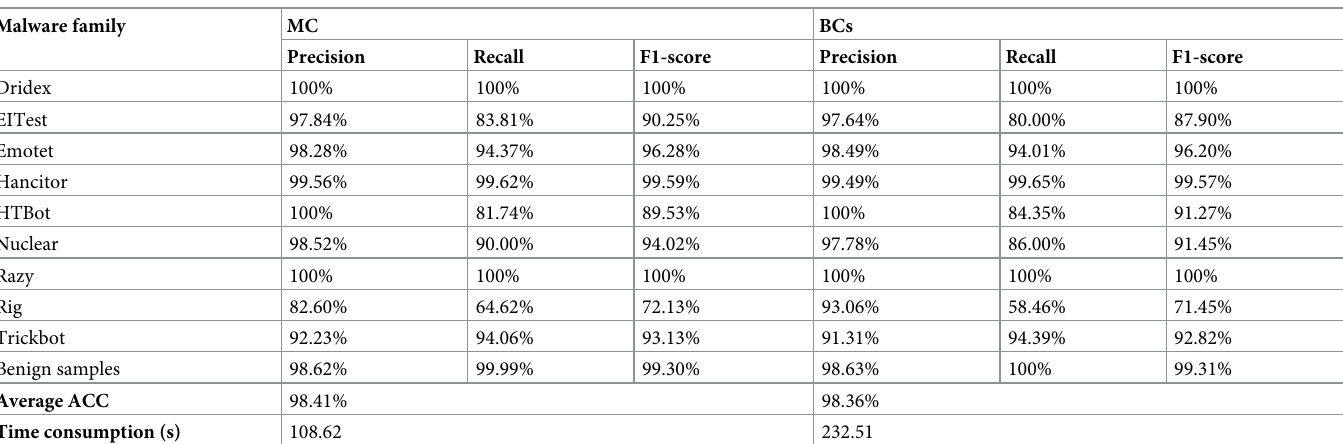
Table 6. Comparison of the two options.